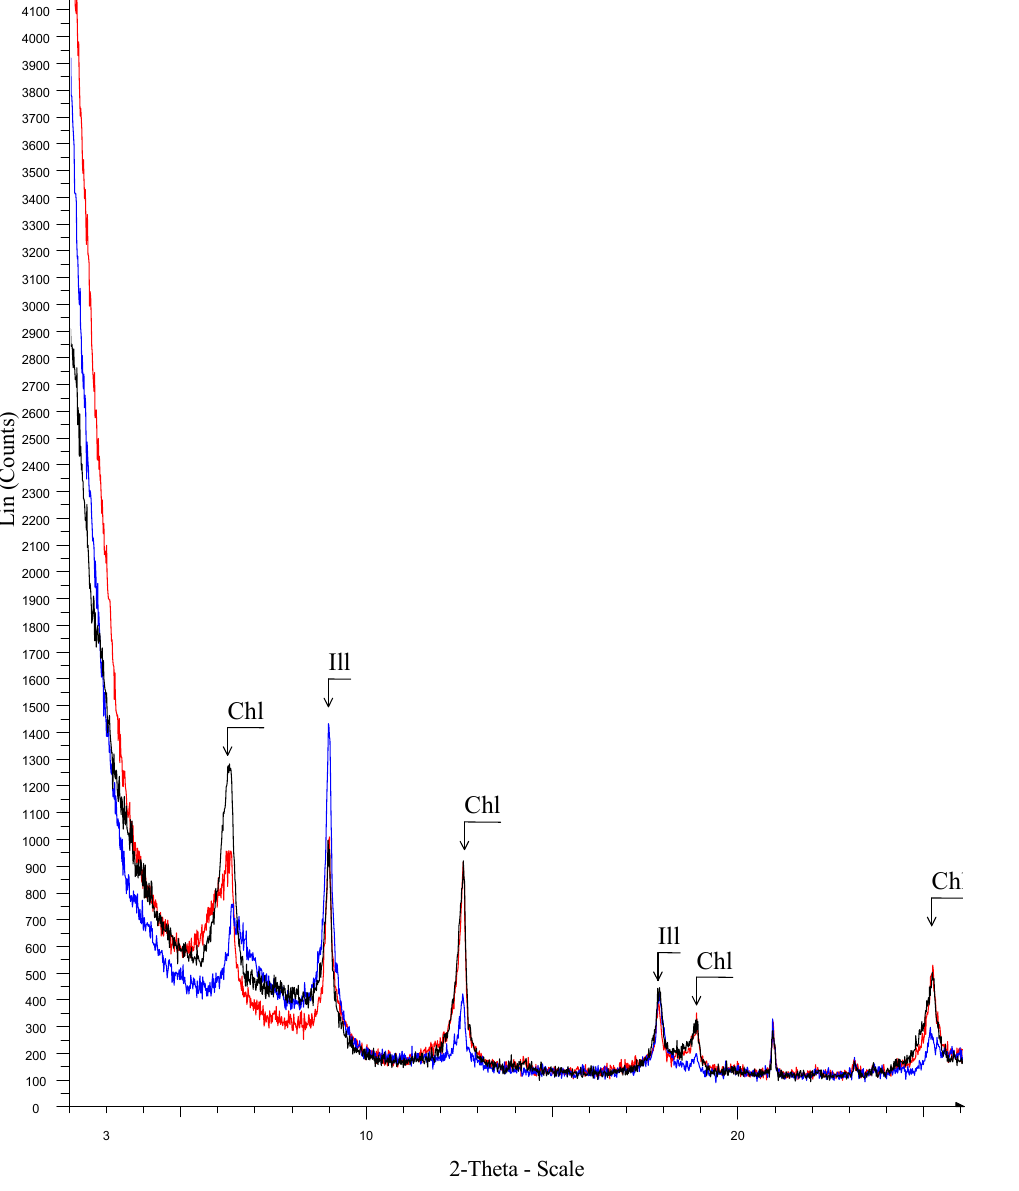
Figure A4. Representative composite diffractogram of the illitic-chloritic clayey raw materials es- tablished according to the clay minerals content revealed from the <2 μ m fraction. The diffraction pattern of each preparation is intentionally equally displaced in respect to the Y axis for obtaining the better visual. Abbreviations: Ill = Illite, Chl = Chlorite. Red line = heated at 490 °C; Blue line = ethylene-glycol solvation; Black line = air dried .